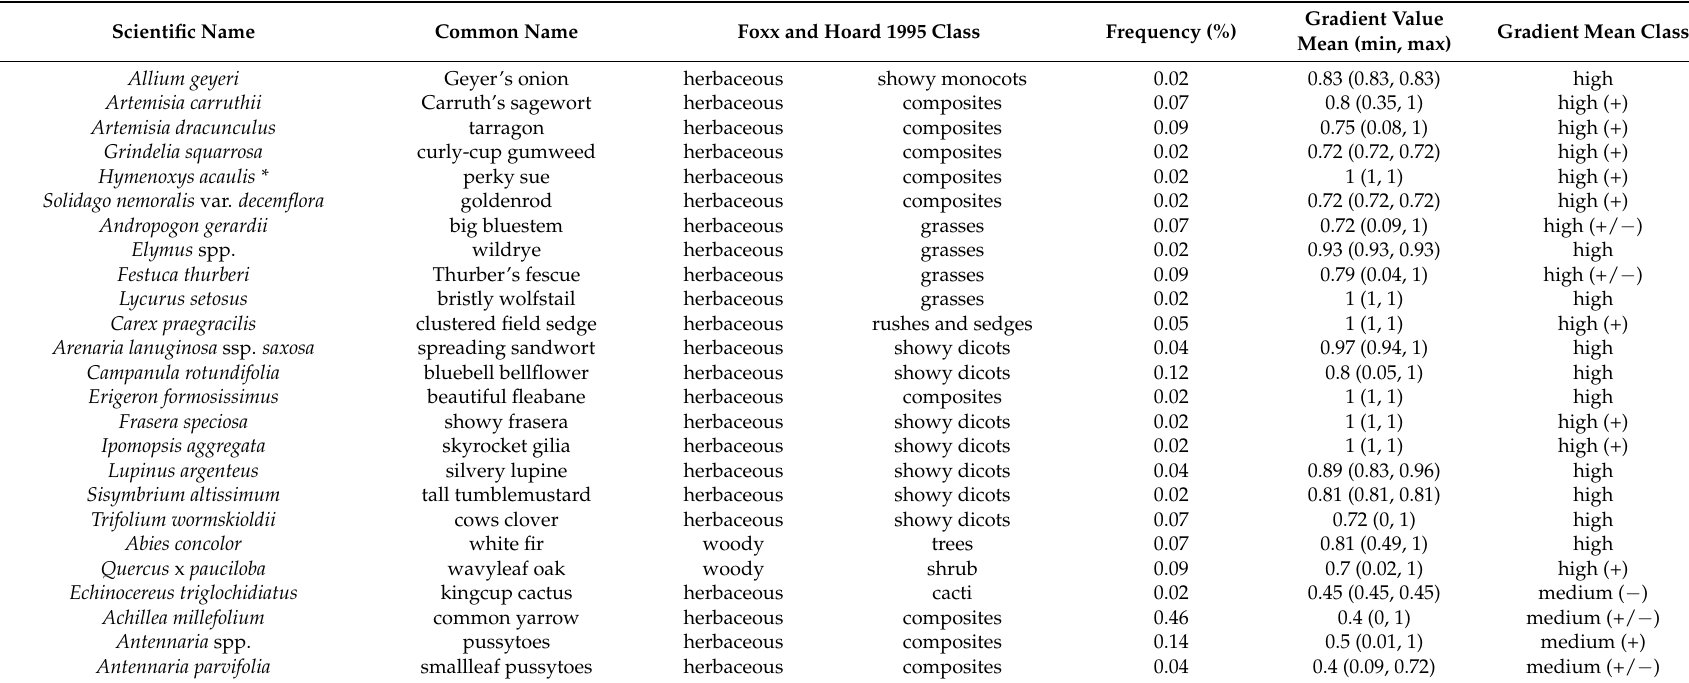
Table A1. Species recorded at the 57 field plots ( n = 159), including scientific and common names. Additional information includes: forest understory designation (marked with an asterisk), species classifications (Foxx and Hoard 1995), observed frequency across sites, Las Conchas refugial gradient value (mean, min, max) and high, medium and low refugial gradient classes based on mean value (high ≥ 0.7; medium 0.4 to 0.7; low < 0.4). Please note: minimum gradient values are truncated to two decimal places, so zero values are actually >0, but <0.001. Species observed at one or more field sites where the gradient value had shifted dramatically (i.e., ≥ |0.5|) since the previous fire are indicated with a symbol following the gradient mean class: (+) = higher post-Las Conchas; ( − ) = lower post-Las Conchas; (+/ − ) = observed at some sites with an increased value and some with a decreased value. The remainder of species were not observed at places with extreme shifts or were only recorded in places that had not burned in the La Mesa, Dome or Cerro Grande fires. Nomenclature follows: USDA, Natural Resources Conservation